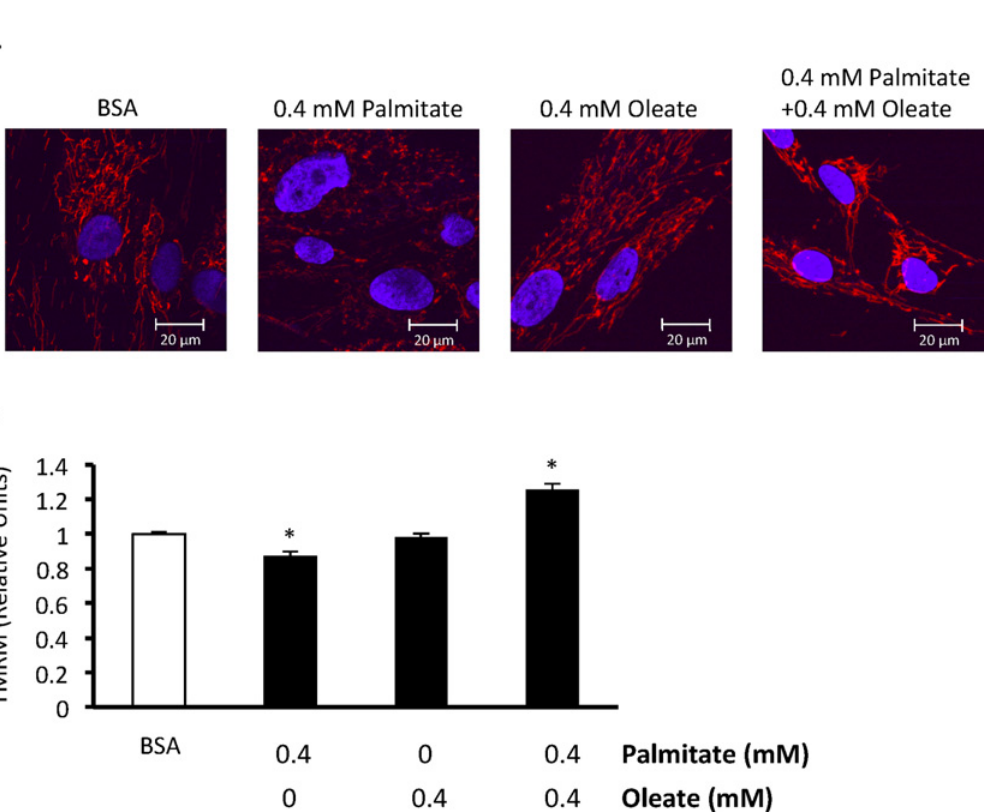
Fig 3. Effect of 24 hr exposure to palmitate and oleate on human BMMSC mitochondrial membrane potential. A) Images of tetramethylrhodamine methyl ester (TMRM) stained bone marrow mesenchymal stem cells (BMMSCs) treated for 24 hr with indicated treatments. B) Relative TMRM levels. BMMSCs were treated for 24 hr with 0.55 mM bovine serum albumin (BSA) alone or palmitate and/or oleate bound to 0.55 mM albumin. TMRM and Hoechst stain were added to the medium to measure mitochondrial membrane potential and stain nuclei, respectively, and images were taken. All fatty acid treated groups were also treated with media supplemented with 0.55 mM albumin in addition to the type and amount of fatty acid indicated in the figures. 4 separate observations. Values are shown as the mean ± SEM. * Significantly different from the BSA